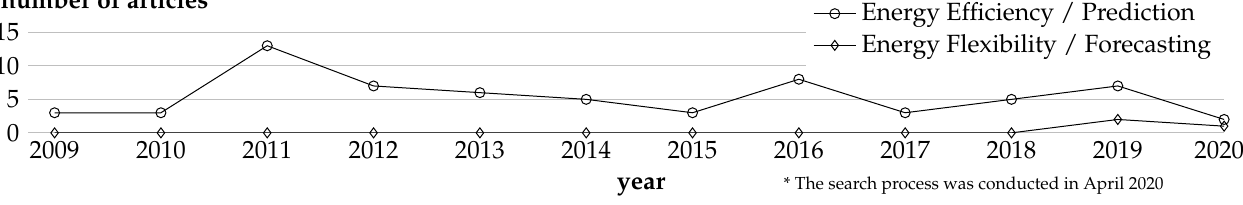
Figure 7. Number of articles over time for the categories Focus and